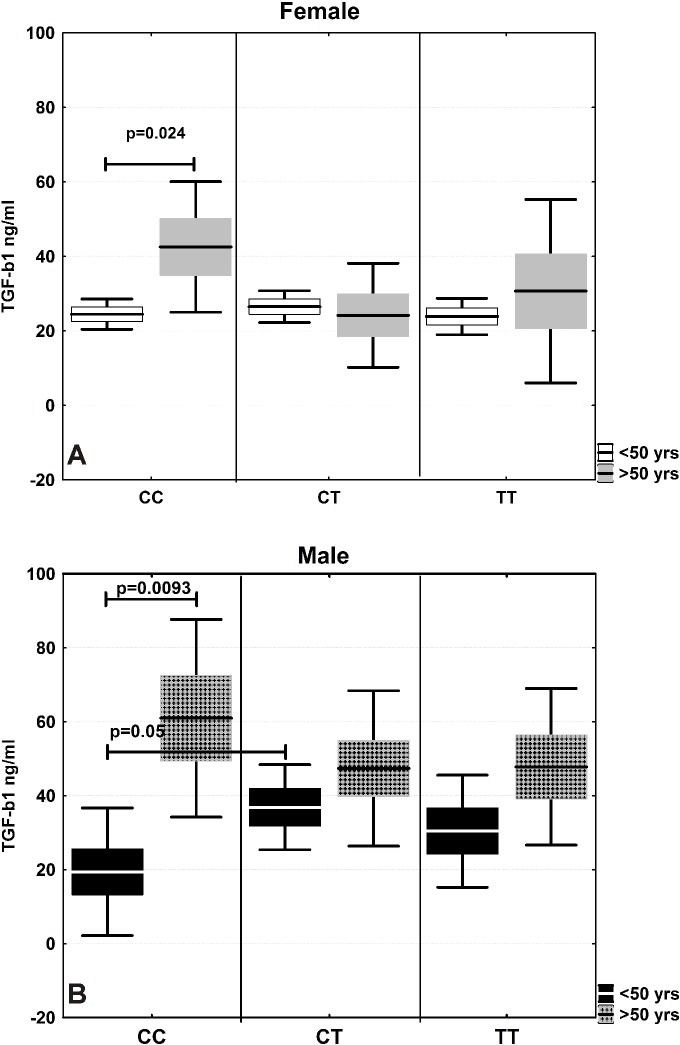
TGF-β1 serum levels in controls, aged under and over 50 in relation to TGFB1-509 polymorphism.(A) Females over 50 (>50) compared to females under 50 (<50). (B) Males over 50 (>50) compared to males under 50 (<50). The results are presented as the mean value ±SE (box) with a ±0.95 confidential interval (whisker).The statistical significance of the U-test is shown as the p-value.